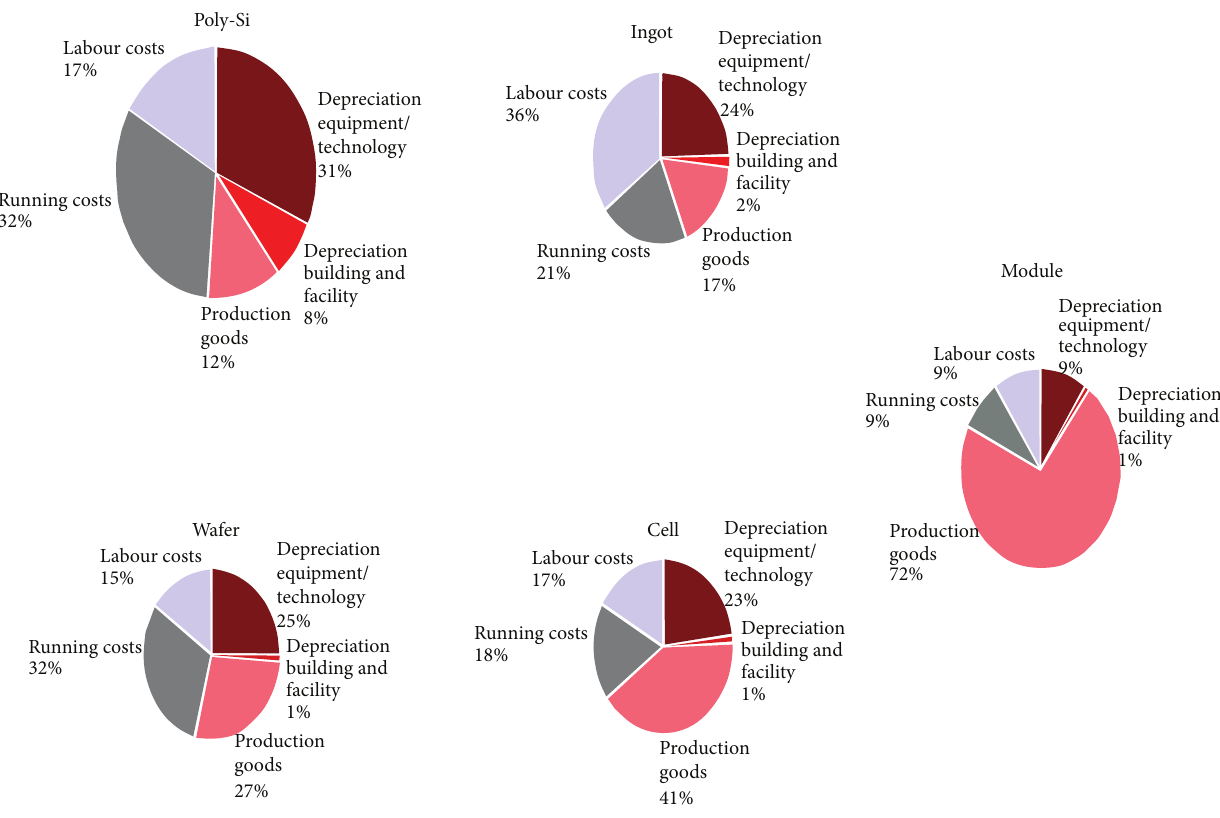
Figure 10: Sharing the cost of processing photovoltaic modules [22].